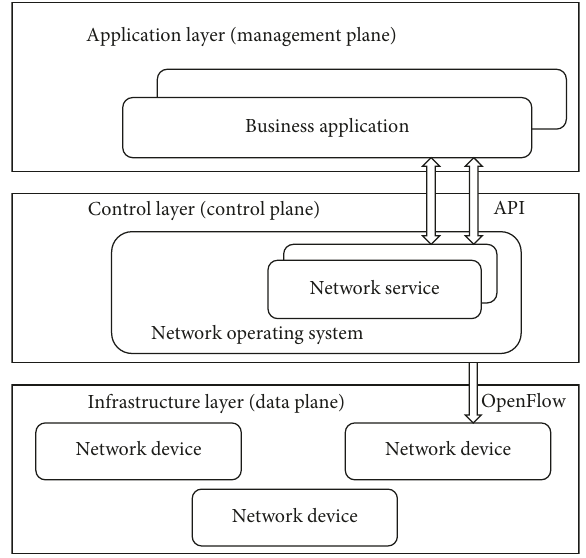
Figure 1: The structure of Software Defined Networking